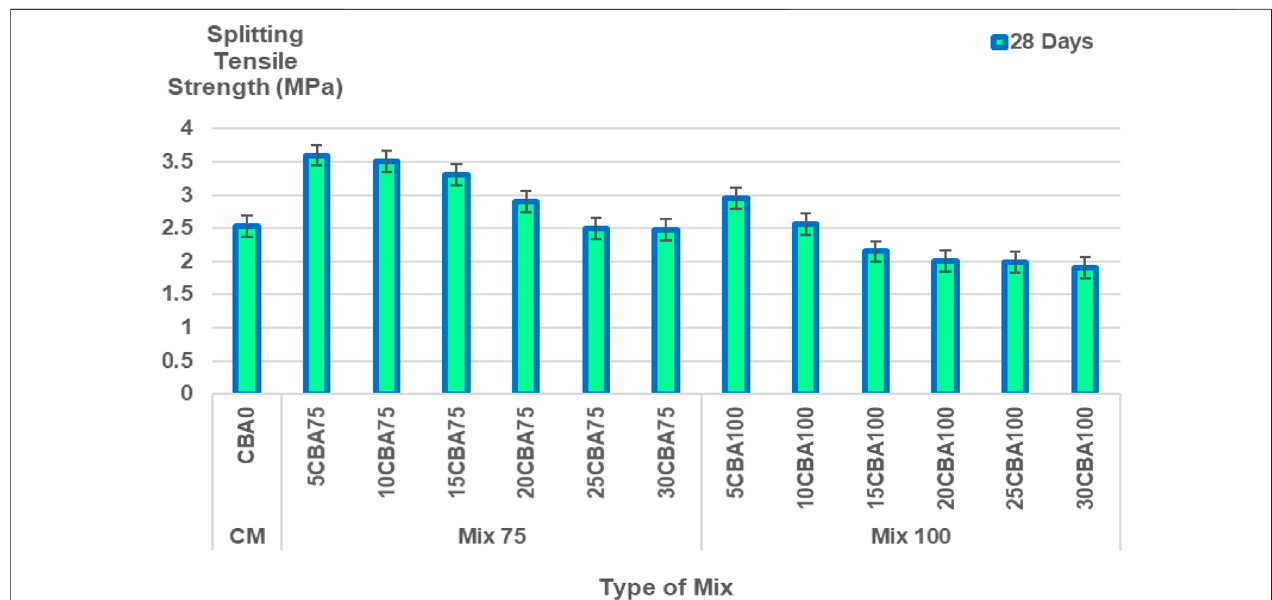
FIGURE 8 | Splitting tensile strength (MPa) of CM, Mix 75, and Mix 100 in 28 curing days.